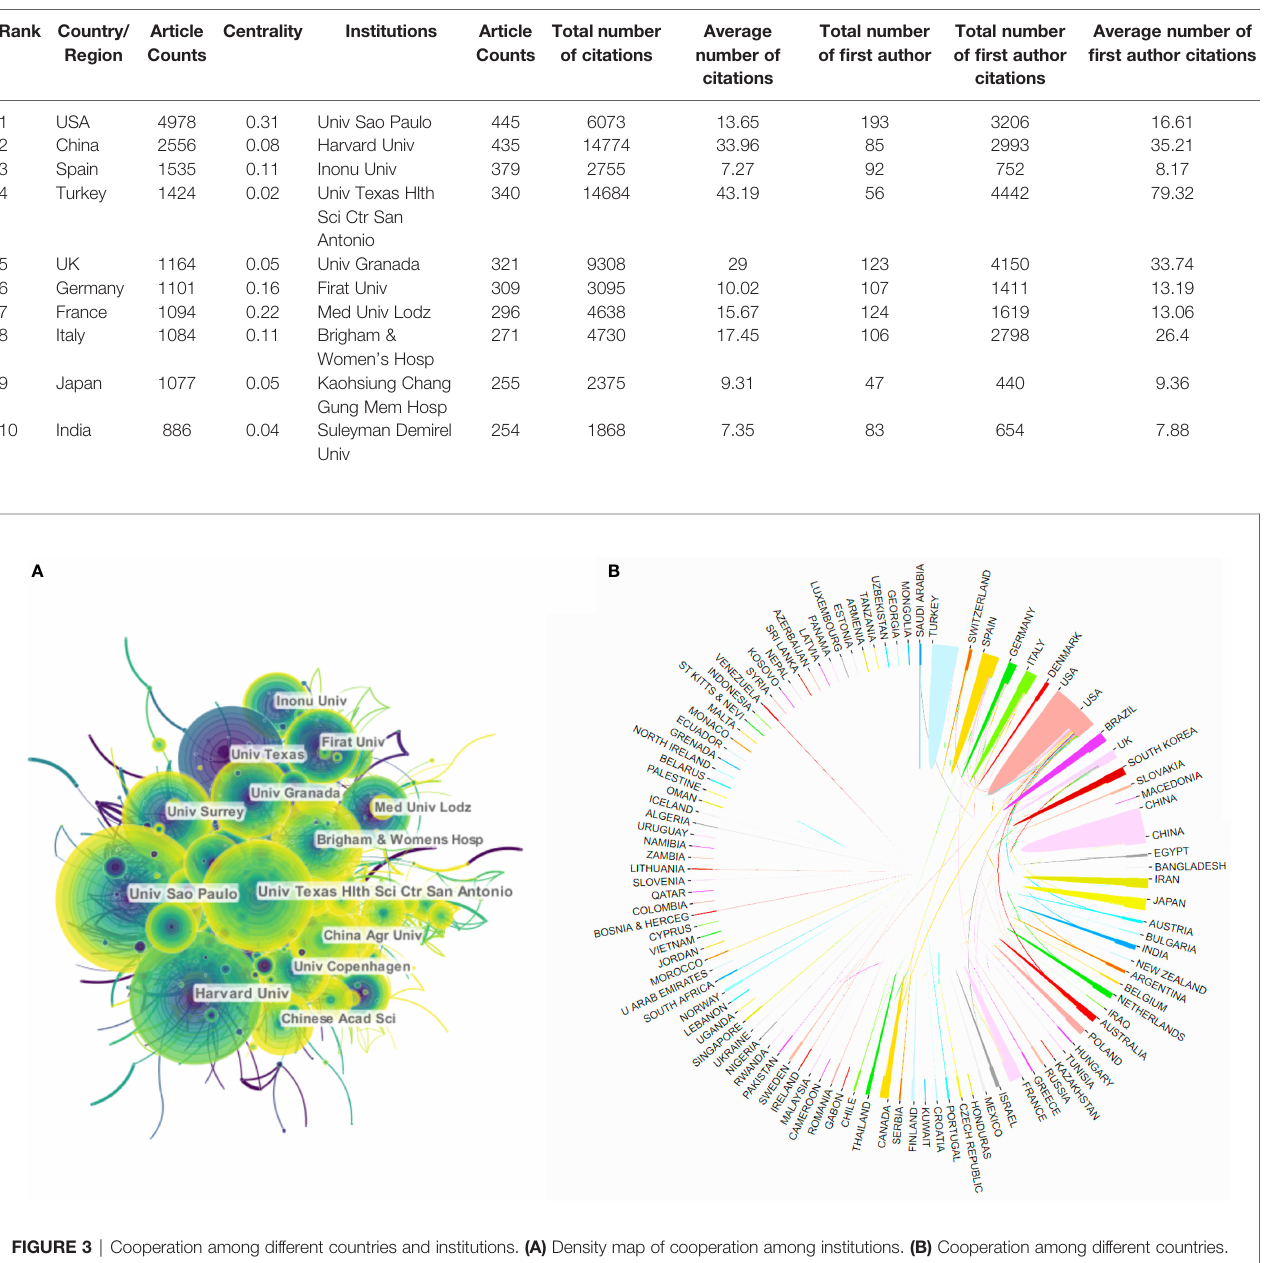
Frontiers in Endocrinology |